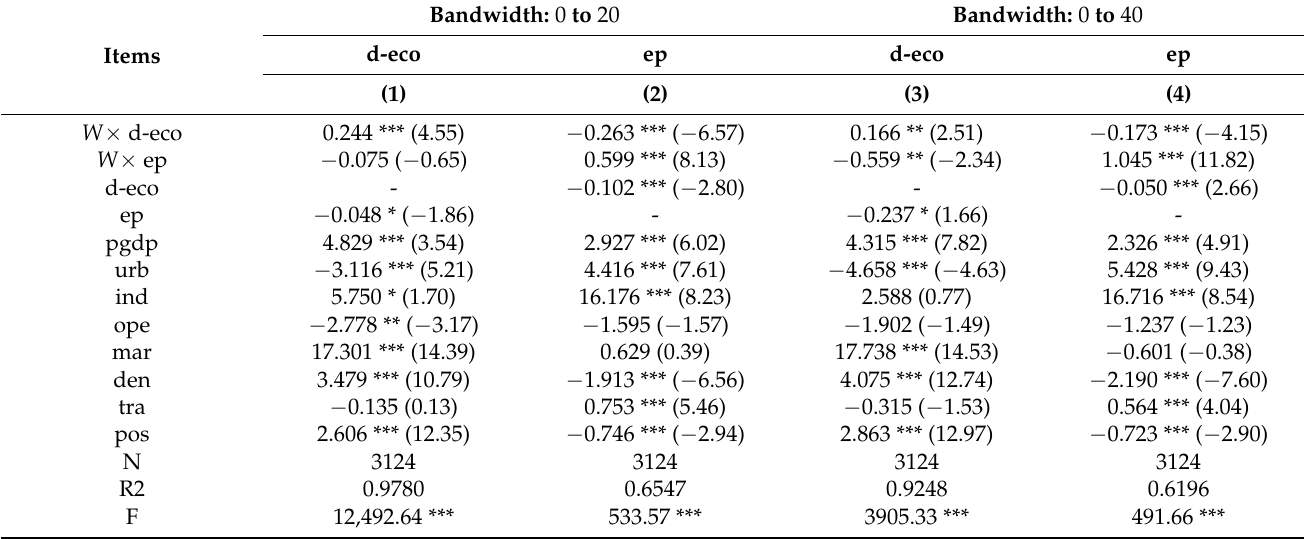
Table 5. Results of bandwidth adjustment.